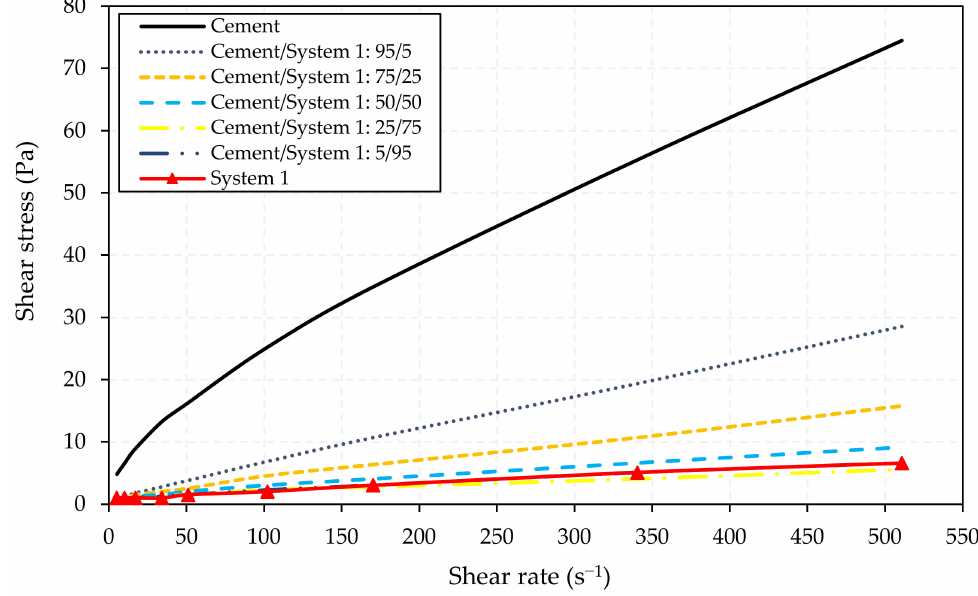
Figure 8. Rheological behavior of cement slurry / cleanup fluid (system 1) mixture and pure components.